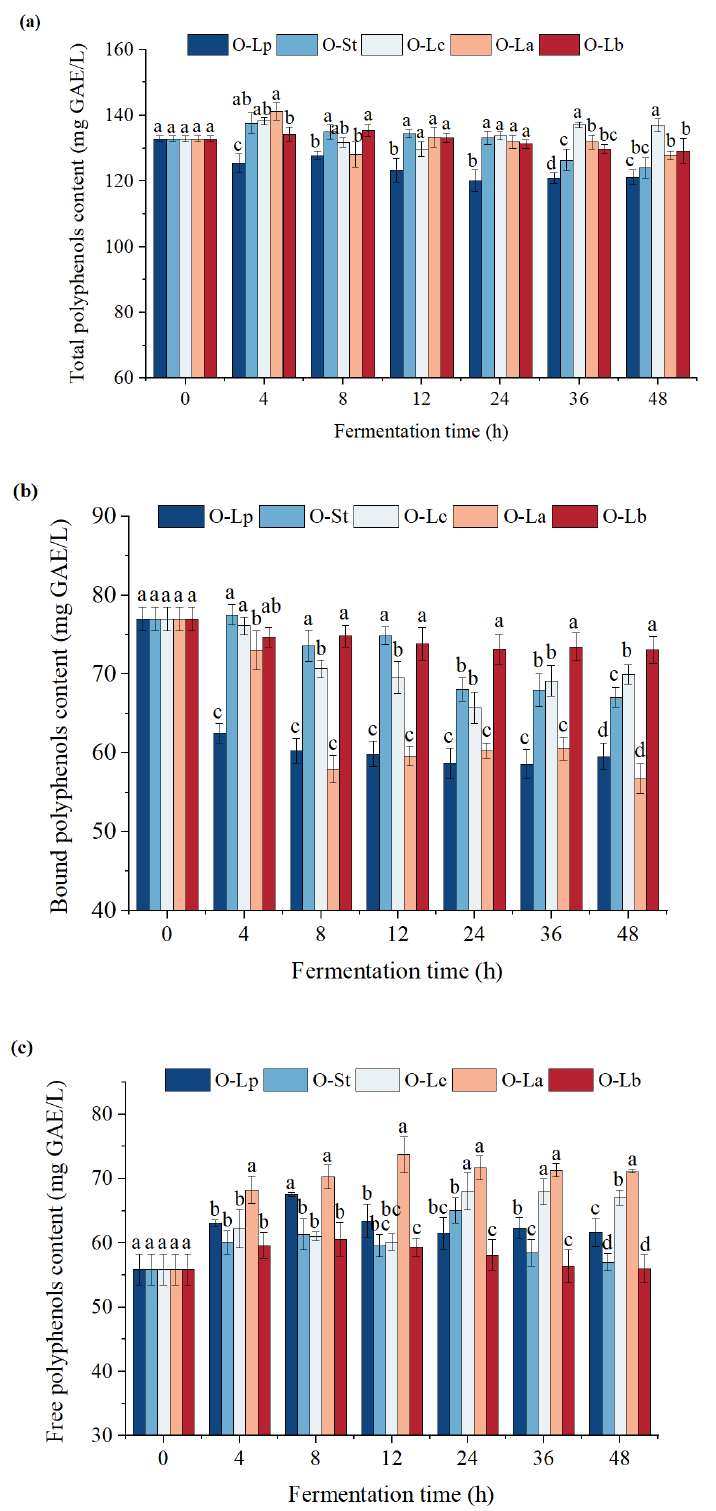
Figure 3. Contents of total polyphenols ( a ), bound polyphenols ( b ) and free polyphenols ( c ) in samples of different strains at different fermentation times. Different letters indicate significant differences among different strains a given fermentation time ( p < 0.05). O-Lp, sample fermented with L. plantarum ; O-La, sample fermented with L. acidophilus ; O-Lc, sample fermented with L. casei ; O-Lb, sample fermented with L. bulgaricus ; O-St, sample fermented with S. thermophilus . h,